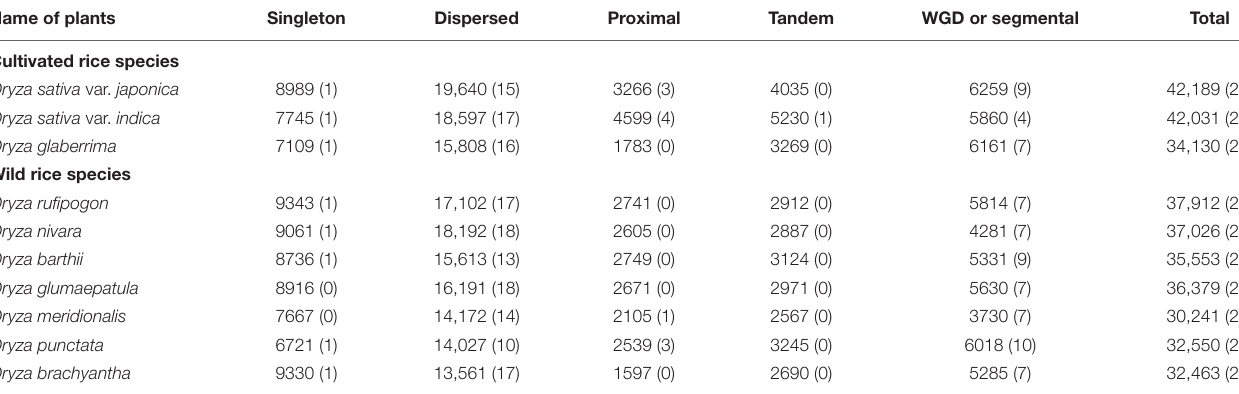
TABLE 4 | Distribution of different modes of gene duplication based on whole genome and START genes (in parentheses) amongst 10 cultivated and wild Oryza species. Name of plants Singleton Dispersed Proximal Tandem WGD or segmental Total Cultivated rice